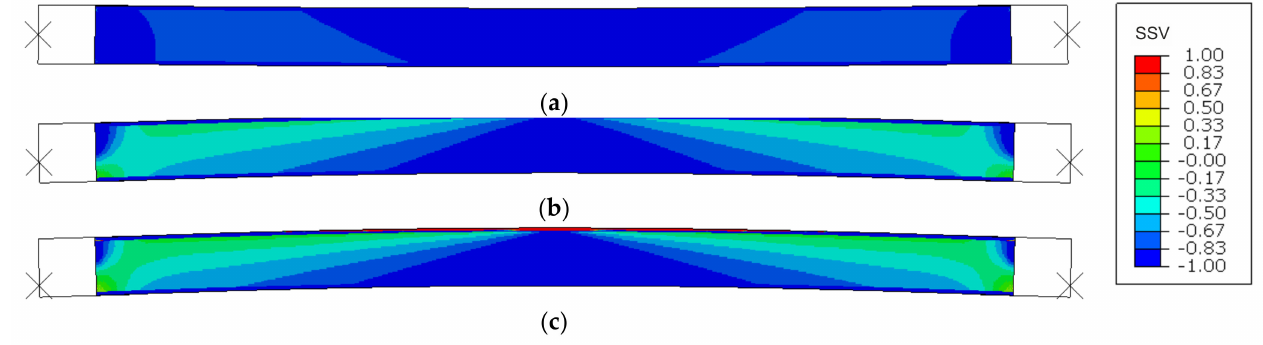
Figure 13. SSV distribution in natural-scale panel compression simulations for ( a ) e0, ( b ) e1, ( c )